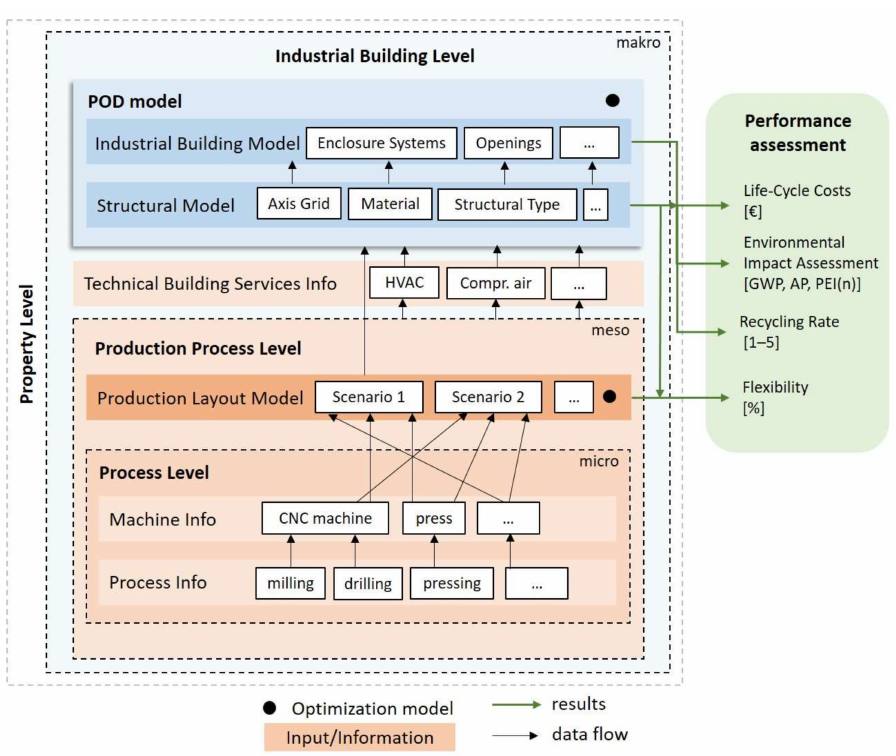
Figure 3. Framework for integrated industrial building design to enable flexible structural and production layout